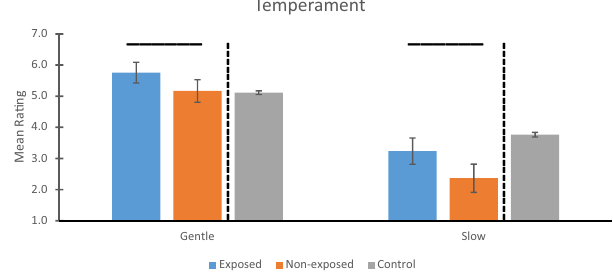
Fig. 4 Temperament. Statistical comparisons between monkeys exposed vs. non-exposed (blue and orange bars, respectively) to wild fi re smoke prenatally show that, compared to non-exposed animals, those exposed to WFS were rated more Gentle ( p = .020) and more Slow ( p = .006) compared to animals not exposed. Overhead bars indicate signi fi cant differences. Mean ratings and 95% Con fi dence Intervals (CI) are shown for Gentle (left panel) and Slow (right panel). All values are adjusted for the covariate. To the right of the dotted lines are the corresponding values for the full control cohort (mean, 95% CI). Comparison of the overlap in CI between the groups in the target cohort with the control cohort revealed that, for Gentle, there was no overlap in CI between controls and exposed animals, but complete overlap for controls and non-exposed animals. For Slow, both exposed and non-exposed animals in the target cohort had CI that were below those of the control cohort ’ s CI. Sample sizes for both temperament measures were n = 52, 37, and 2483 for exposed, non- exposed, and control groups, respectively. Source data are presented in a Source Data fi